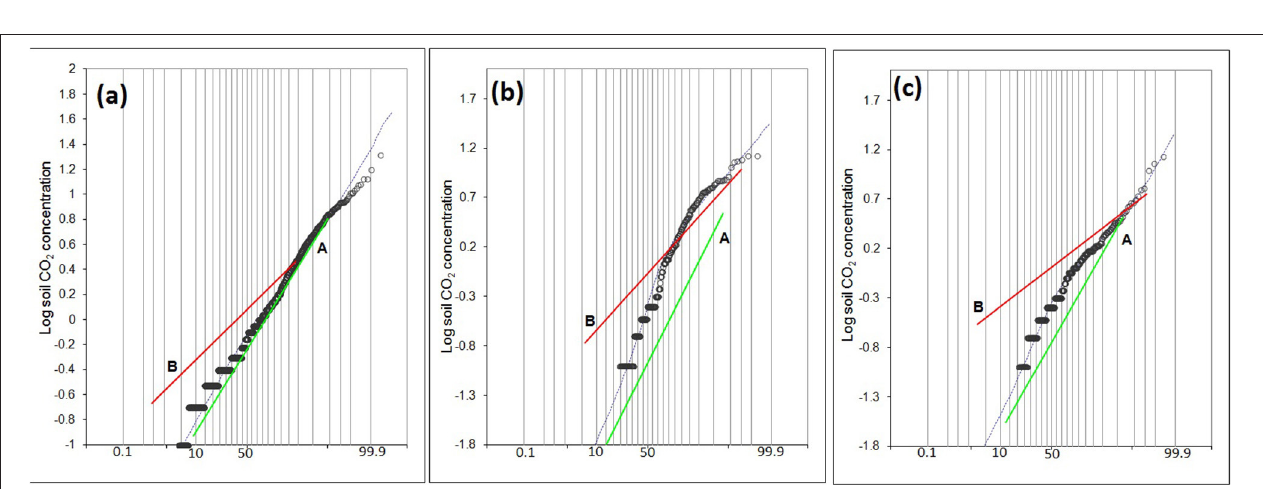
FIGURE 9 | Probability plots of soil CO 2 concentrations measured at Faial (A) , Pico (B) , and São Jorge (C) islands. Green and red lines represent populations A and B,